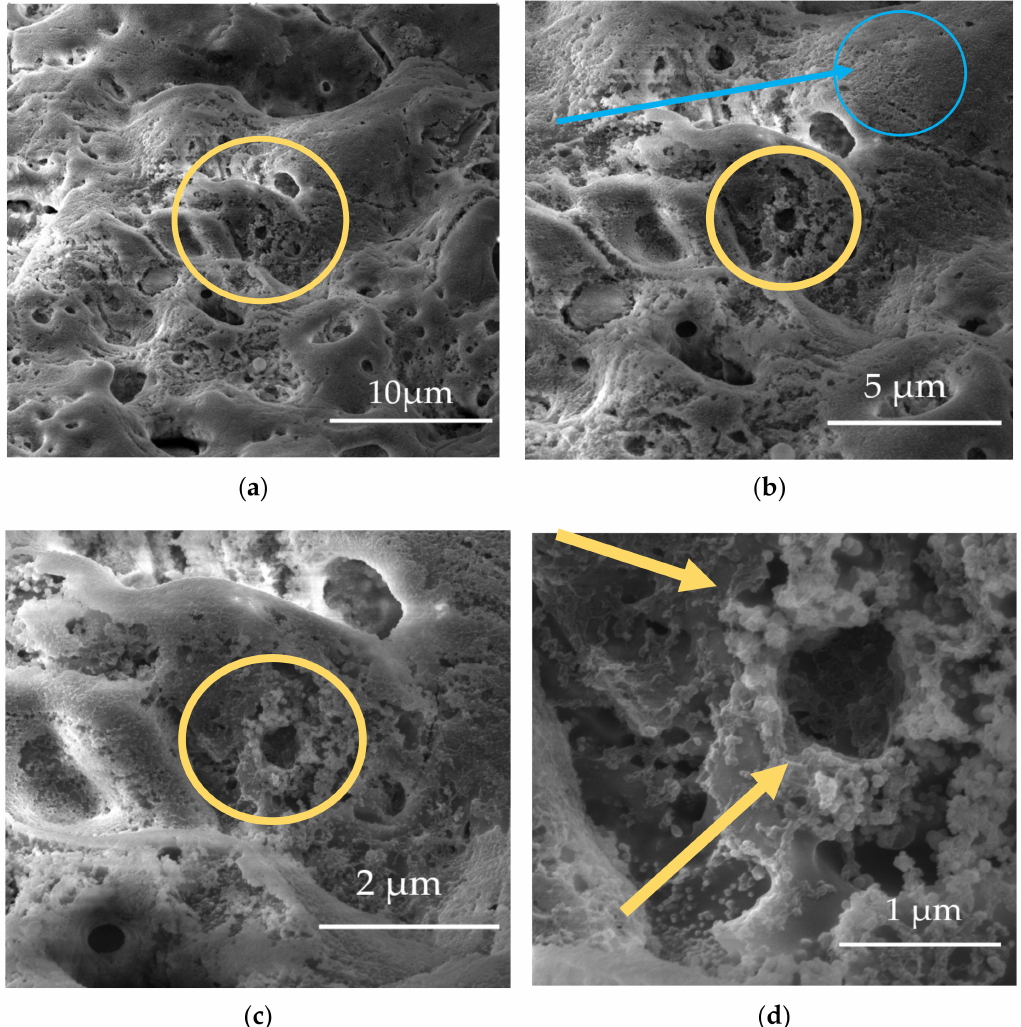
Figure 10. ( a – d ) SEM images of PEO coating degradation in 0.1 M NaCl after 24 h of exposure with different magnifications, ( a – d ) different magnifications of the degraded PEO